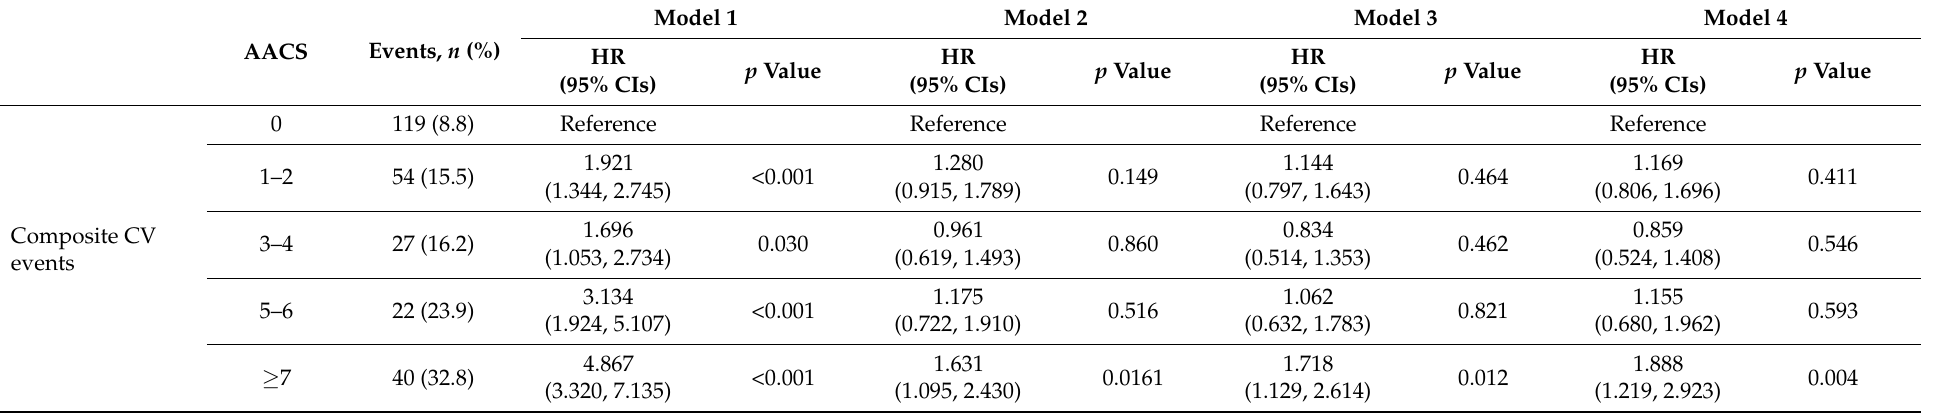
Table 2. Cox regression analysis of AACS for the primary outcome (non-fatal CV events and all-cause death).